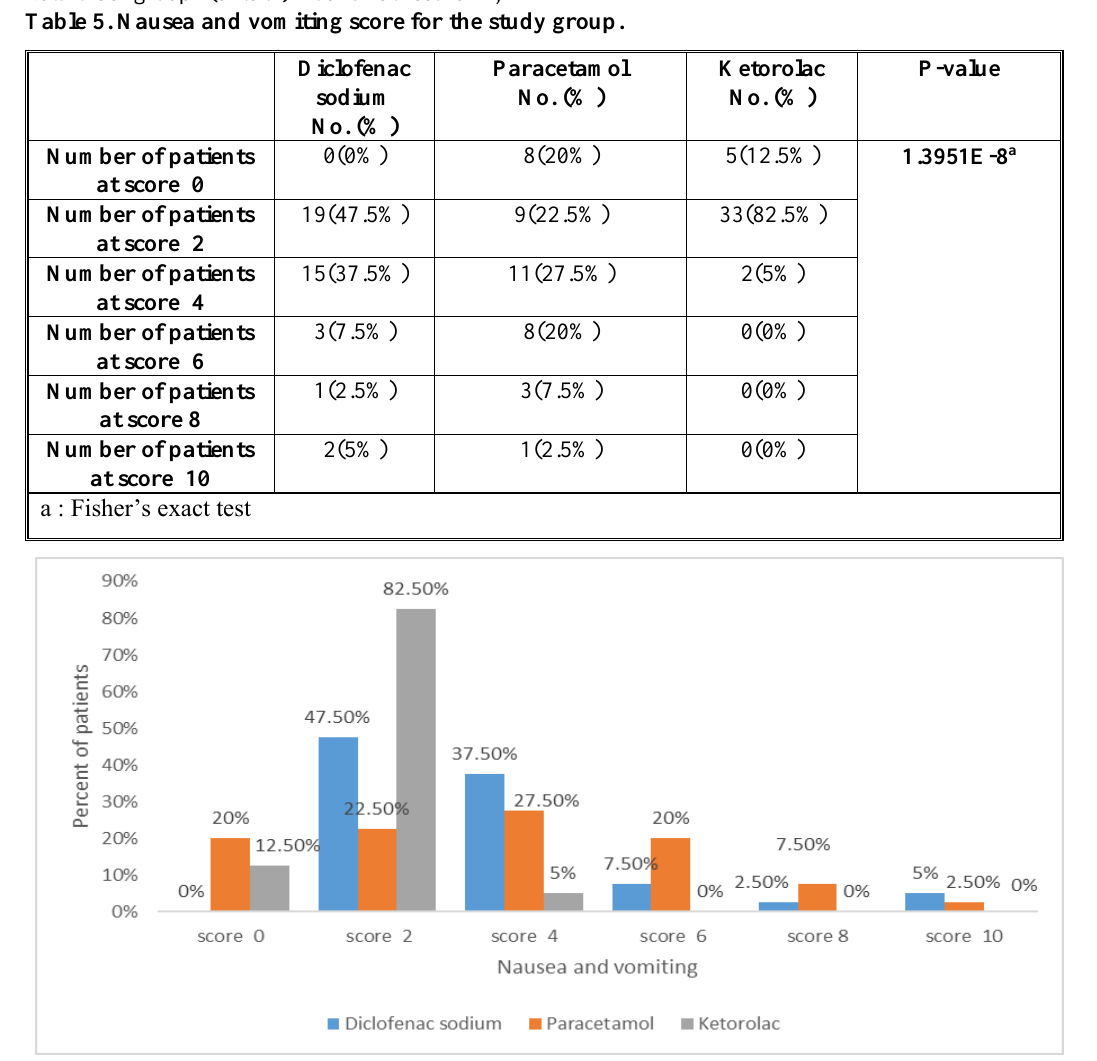
Figure 4. Percent of frequency of nausea and vomiting score for the study groups. Regarding bleeding after surgery, compared to the number of patients without there is no significant difference between the bleeding (p<0.05) as shown in (table 6). number of patients with bleeding when Table 6.Bleeding after